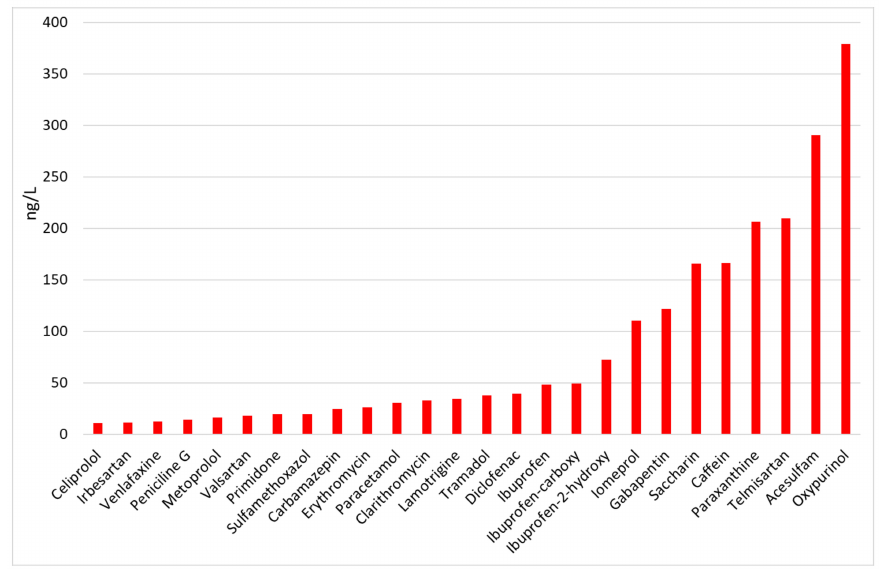
Figure 6. Long-term average concentrations of PPCPs on profile No. 5 Sojovice weir.